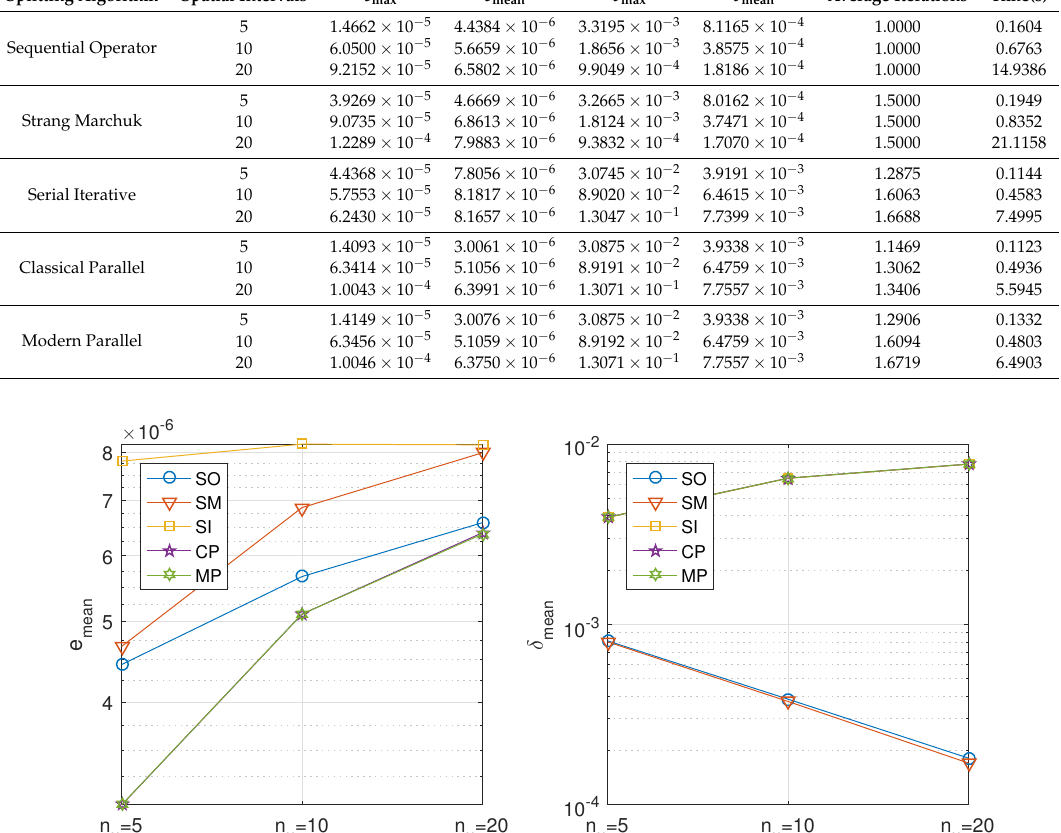
Figure 18. Fractional diffusion equation, balanced decomposition. Precision of the proposed methods: sequential iterative SI, classical parallel CP, and modern parallel MP, compared with the classical ones: sequential operator SO and Strang–Marchuk SM, for 320 temporal steps and different number of spatial